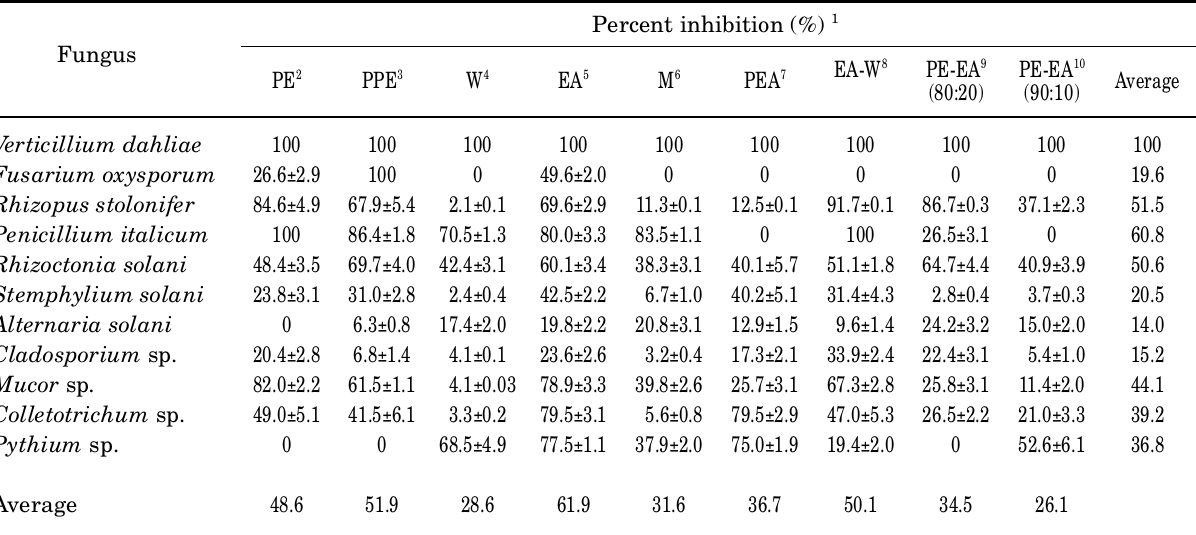
Table 4. Inhibition of fungal growth by crude extracts from the roots of Ferula harmonis